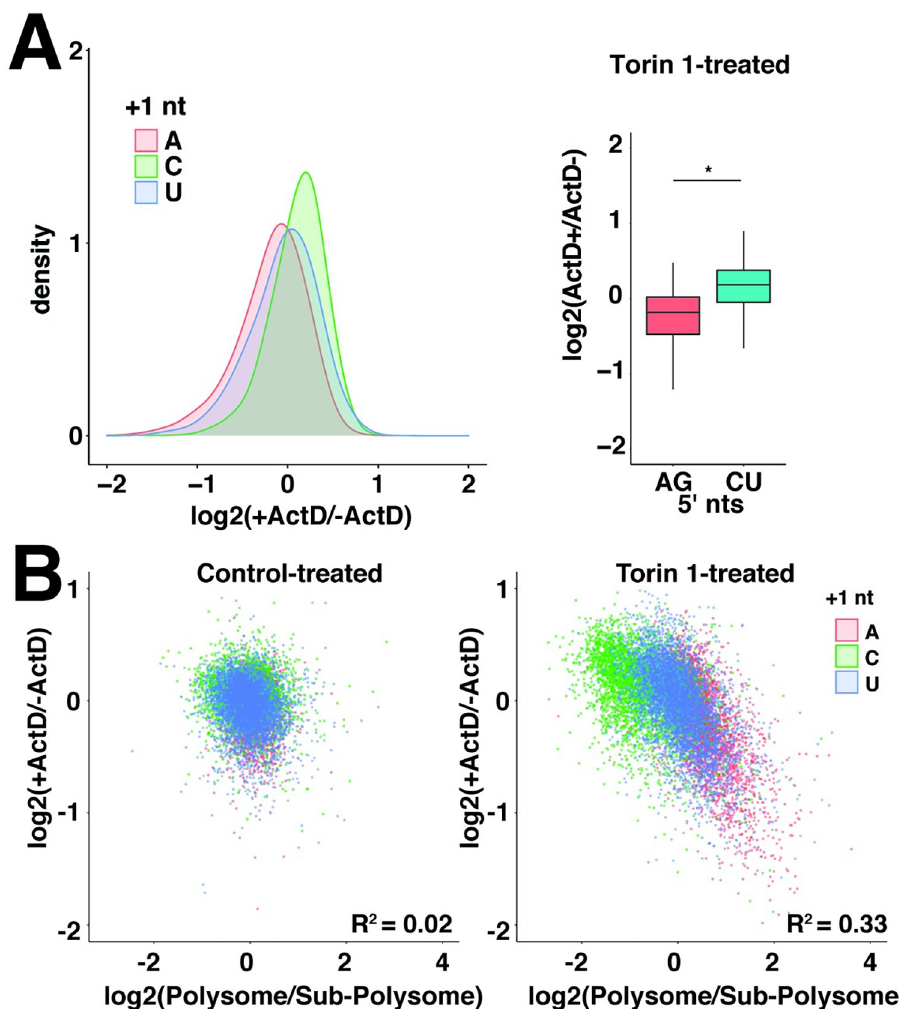
Fig 5. Translation and stability functions are correlated when cap-dependent translation is inhibited. (A) Large variation in library mRNA decay rates under mTOR-inhibited conditions. HeLa cells expressing library mRNAs were treated with 250 nM Torin 1 for 2 h, and then with 2 μ g/mL Actinomycin D for 0 or 2 h in 2 biological replicates. Libraries prepared from extracted mRNA were analyzed to determine relative changes in levels between ActD-treated (ActD+) and untreated (ActD-) conditions. Left panel: Log2 changes in ActD+ vs ActD- levels are plotted separately for mRNAs initiating with the indicated nucleotide. Right panel: box plots of Log2(ActD+/ActD-) for mRNAs initiating with the indicated nucleotides. Significance by t-test for two biological replicates. � p < 10 − 10 . (B) Comparison of decay and translation rates for library mRNAs under control and mTOR-inhibited conditions. Translation rates (Polysome/Sub-polysome) from Fig 4B and decay rates from (A) and Fig 2D for library mRNAs under mTOR-inhibited and control conditions. Datapoints are colored by +1